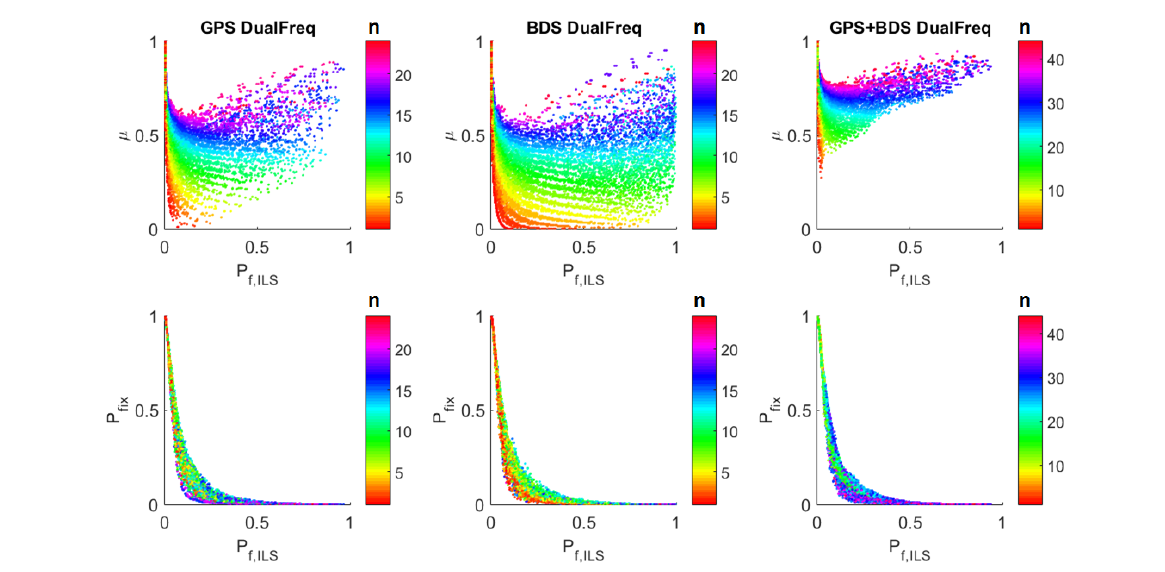
Figure 2. The relation of critical value µ and the fix rate P fix against the Integer Least-Squares (ILS) failure rate P f , ILS for the ratio test (see Equation (5)), with tolerable failure rate P tol panels show µ against P f , ILS , and the lower panels show P fix against P f , ILS . The color bar indicates the number of ambiguities. The left, middle and right panels show the GPS dual frequency, BDSdual frequency and GPS + BDS dual frequency modes,